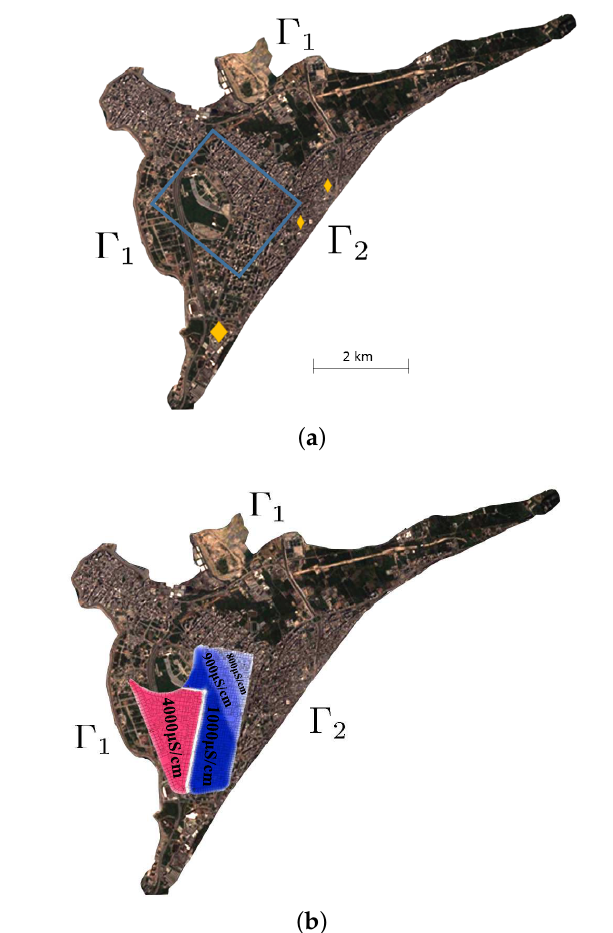
Figure 3. The study area, lower zone of Tripoli city; ( a ) Location of pumping zone: Square in blue represents the area where private wells spread strongly, yellow marks are the public wells, the biggest one represents the four wells located in Bhsas in the south of the aquifer the two other represent respectively El-jisr and Malouleh wells; ( b ) Electrical conductivity in Dam and Farz in 2008